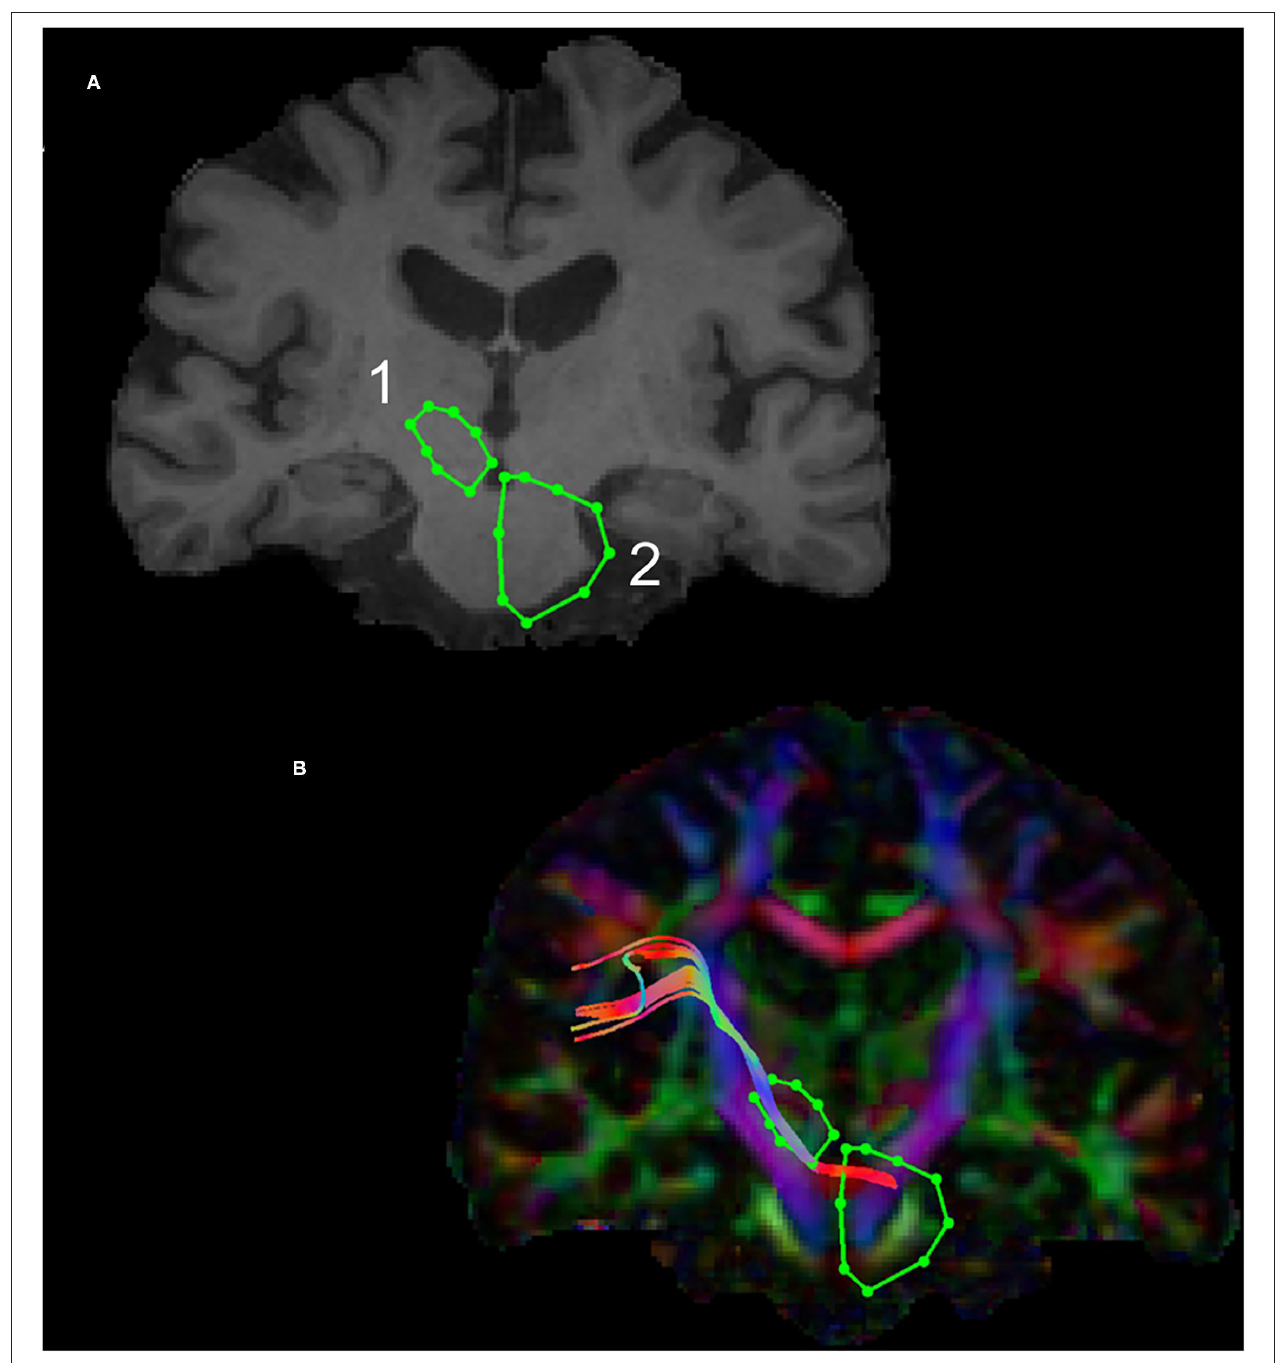
FIGURE 2 | Region of Interest(s) (ROIs) and reconstruction of the subthalamo-ponto-cerebellar tract (SPCT) in an example dataset in coronal view in T1 anatomical (A) and diffusion color-coded image (B) . The first ROI (1) is drawn around the subthalamic nucleus and the second ROI (2) is drawn around the contralateral pons region.